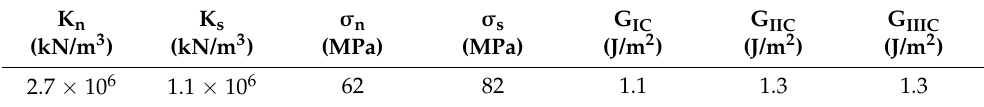
Table 2. Strength properties of adhesive interface.